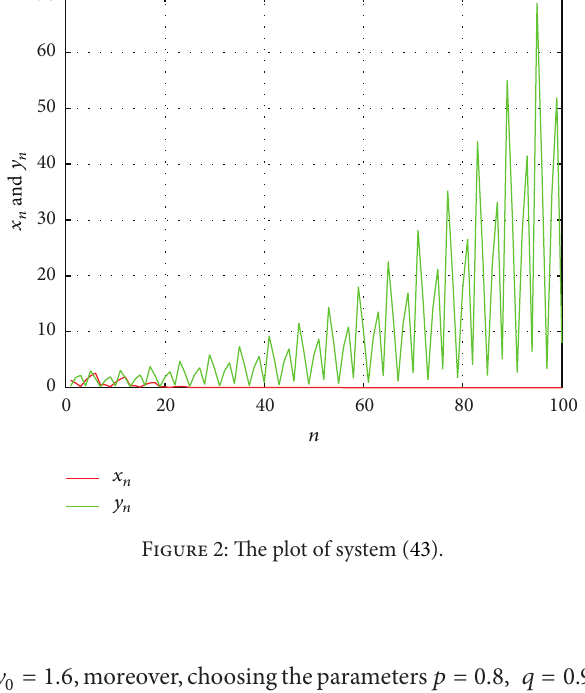
Figure 2: The plot of system